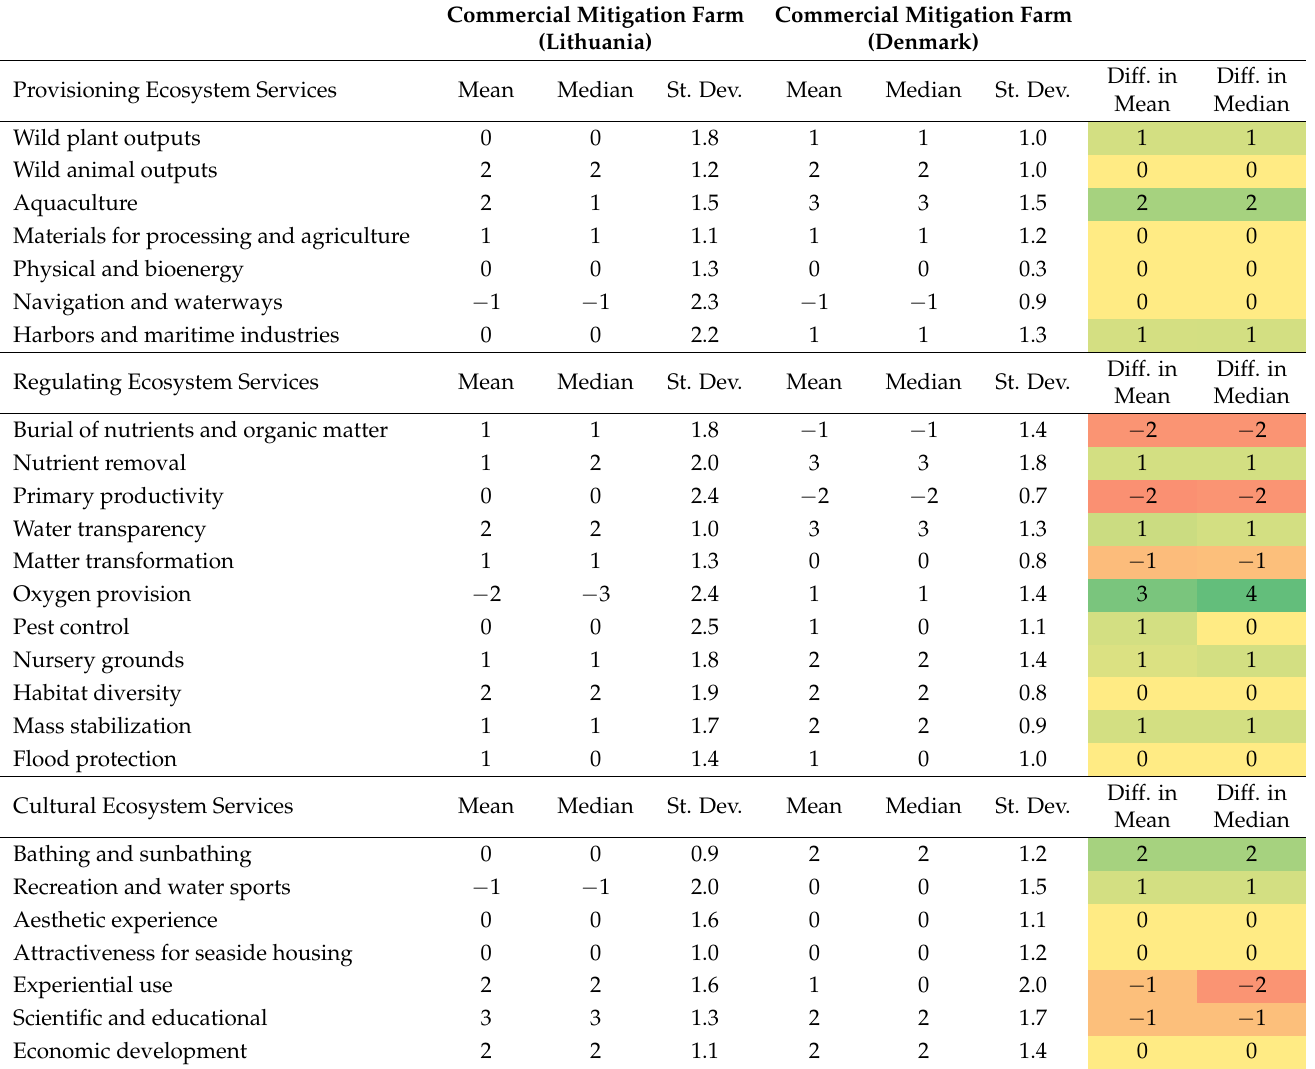
Table 5. Comparison of two ecosystem service assessments assessing the effects (changes) of large- scale commercial mitigation mussel farms based in Lithuanian and Danish coastal waters. The assessment was conducted by experts. The mean and median values were calculated based on the aggregated number of